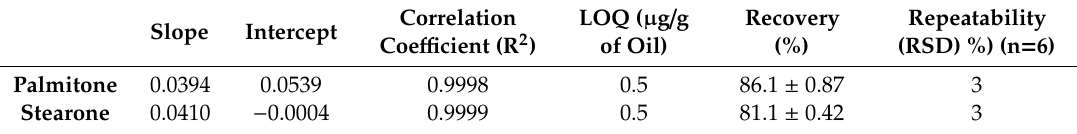
Table 2. Calibration curve in the fat of the cheddar